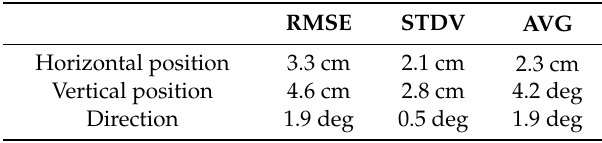
Figure 9. Errors of ( a ) the horizontal position, vertical position, and ( b ) direction measured with the developed GCPs system. Table 3. Root mean square, standard deviation, and average error results measured for horizontal position, vertical position, and direction of the developed GCPs in the field.